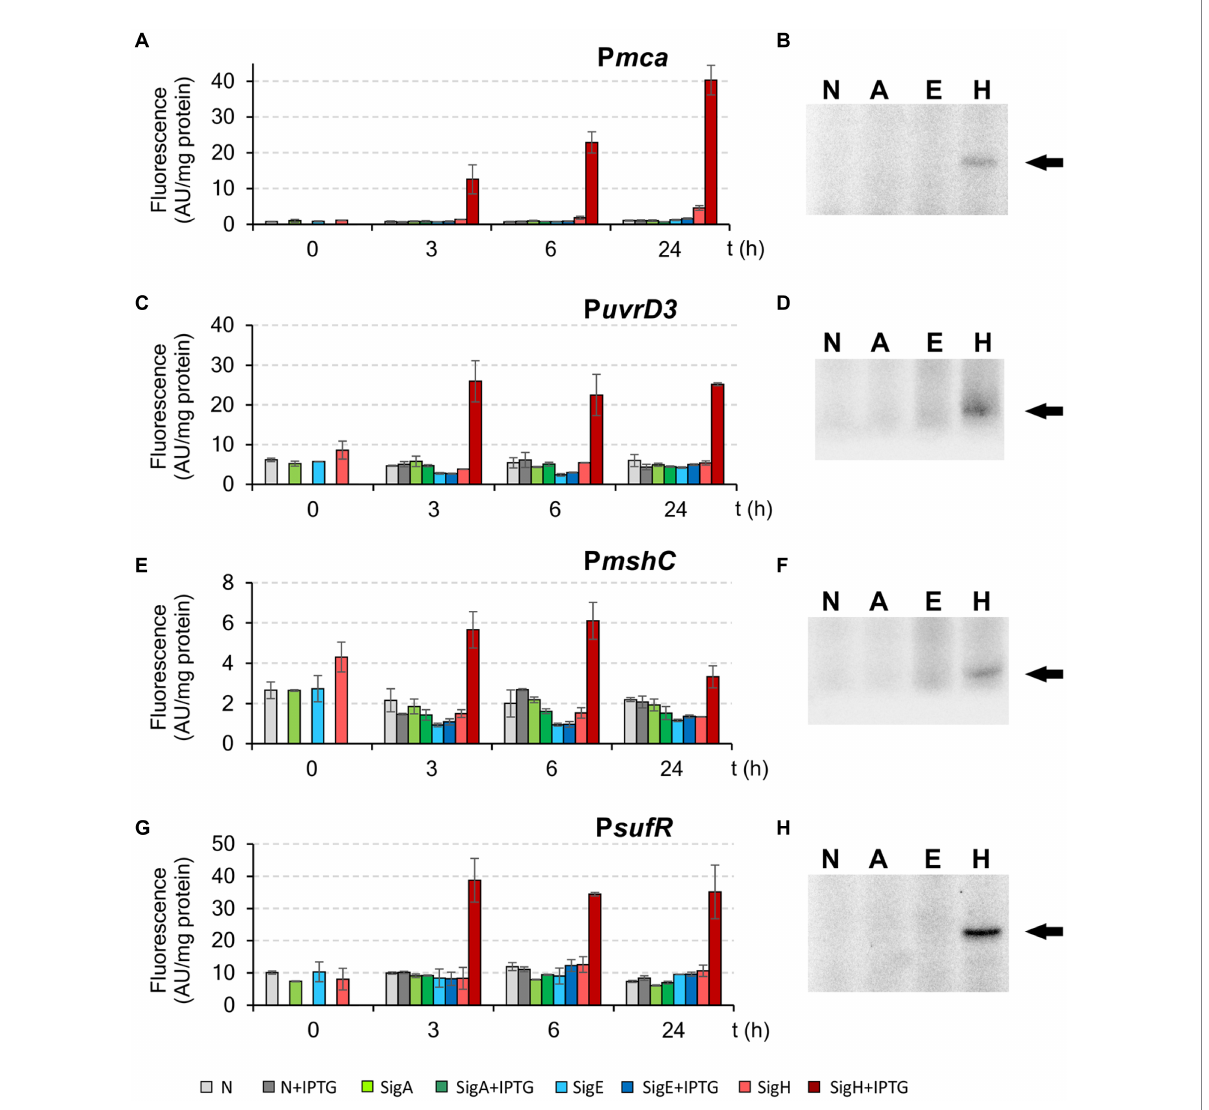
FIGURE 8 Activity of exclusively σ Η -specific promoters P mca , P uvrD3 , P mshC, and P sufR determined by in vivo two-plasmid system (A,C,E,G) and in vitro transcription (B,D,F,H) . The two-plasmid C. glutamicum strains carried the pEC-XT99A constructs overexpressing sigA , sigE, or sigH after IPTG addition (at time point 0) and the promoter-test vector pEPR1 carrying the reporter gfp uv gene downstream of the tested promoter P mca , P uvrD3 , P mshC or P sufR . The strains carrying pEPR1 with the tested promoters and empty pEC-XT99A were used as the controls (gray bars). The fluorescence intensity of cultures without IPTG is shown as light bars; the fluorescence intensity of cultures with IPTG induction is shown as dark bars. AU, arbitrary units. The sigma factors (A, E, H; N = no sigma) used for in vitro transcription are shown above the autoradiograms (B,D,F,H) . The specific transcripts are indicated by arrows. The standard deviations of three biological replicates are depicted as error